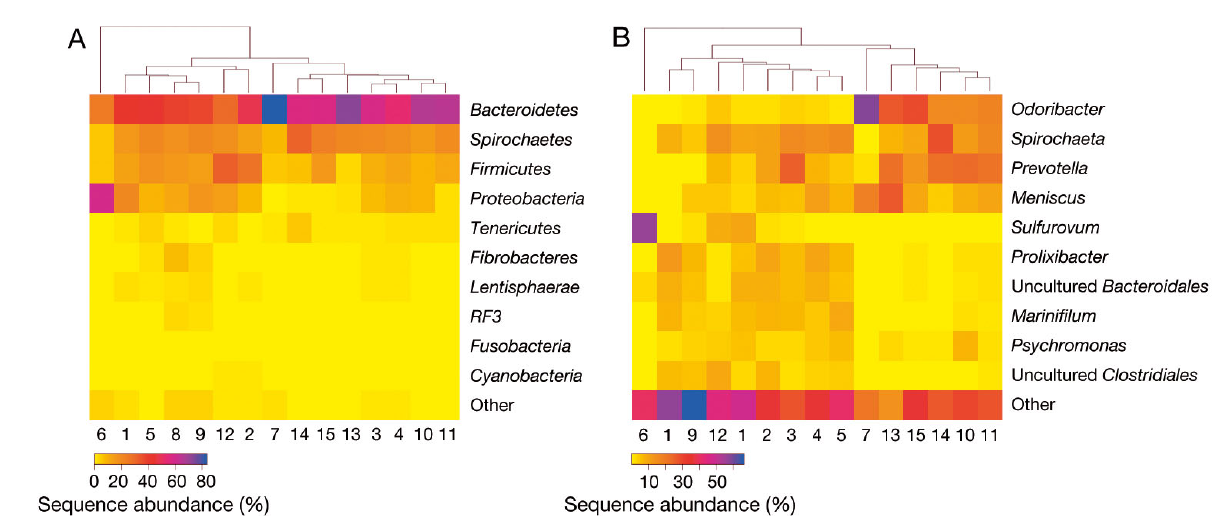
Fig. 2. Heat map visualization of the abundance and distribution of the 10 most abundant taxonomical groups found in aqua- culture site flocculent matter. Indicated in rows are the most abundant (A) phyla and (B) genera. Colours indicate relative se- quence abundance (%), columns represent individual samples labeled by sample number. A dendrogram constructed from relative abundance transformed operational taxonomic unit (OTU) count data using hierarchical clustering of Bray-Curtis dis-